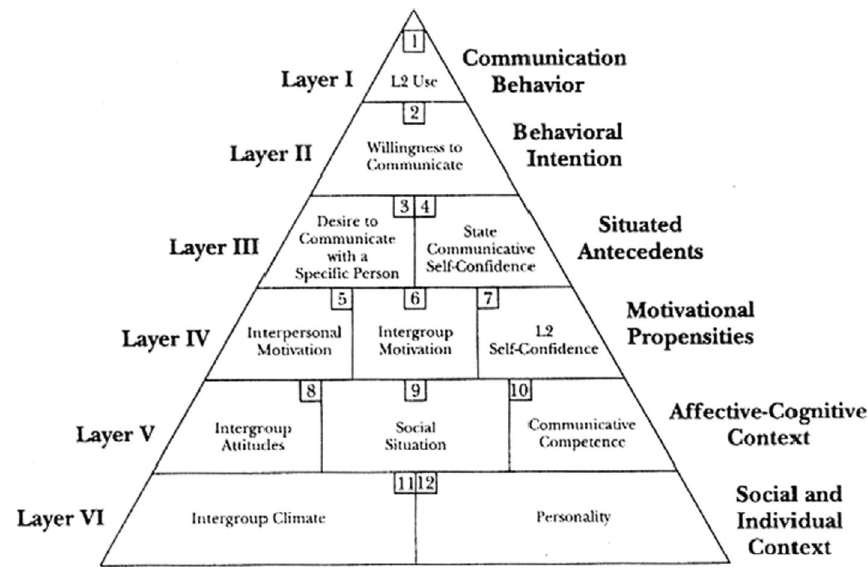
Fig. 1 Heuristic model of WTC in L2 by MacIntyre et al., (1998, p.